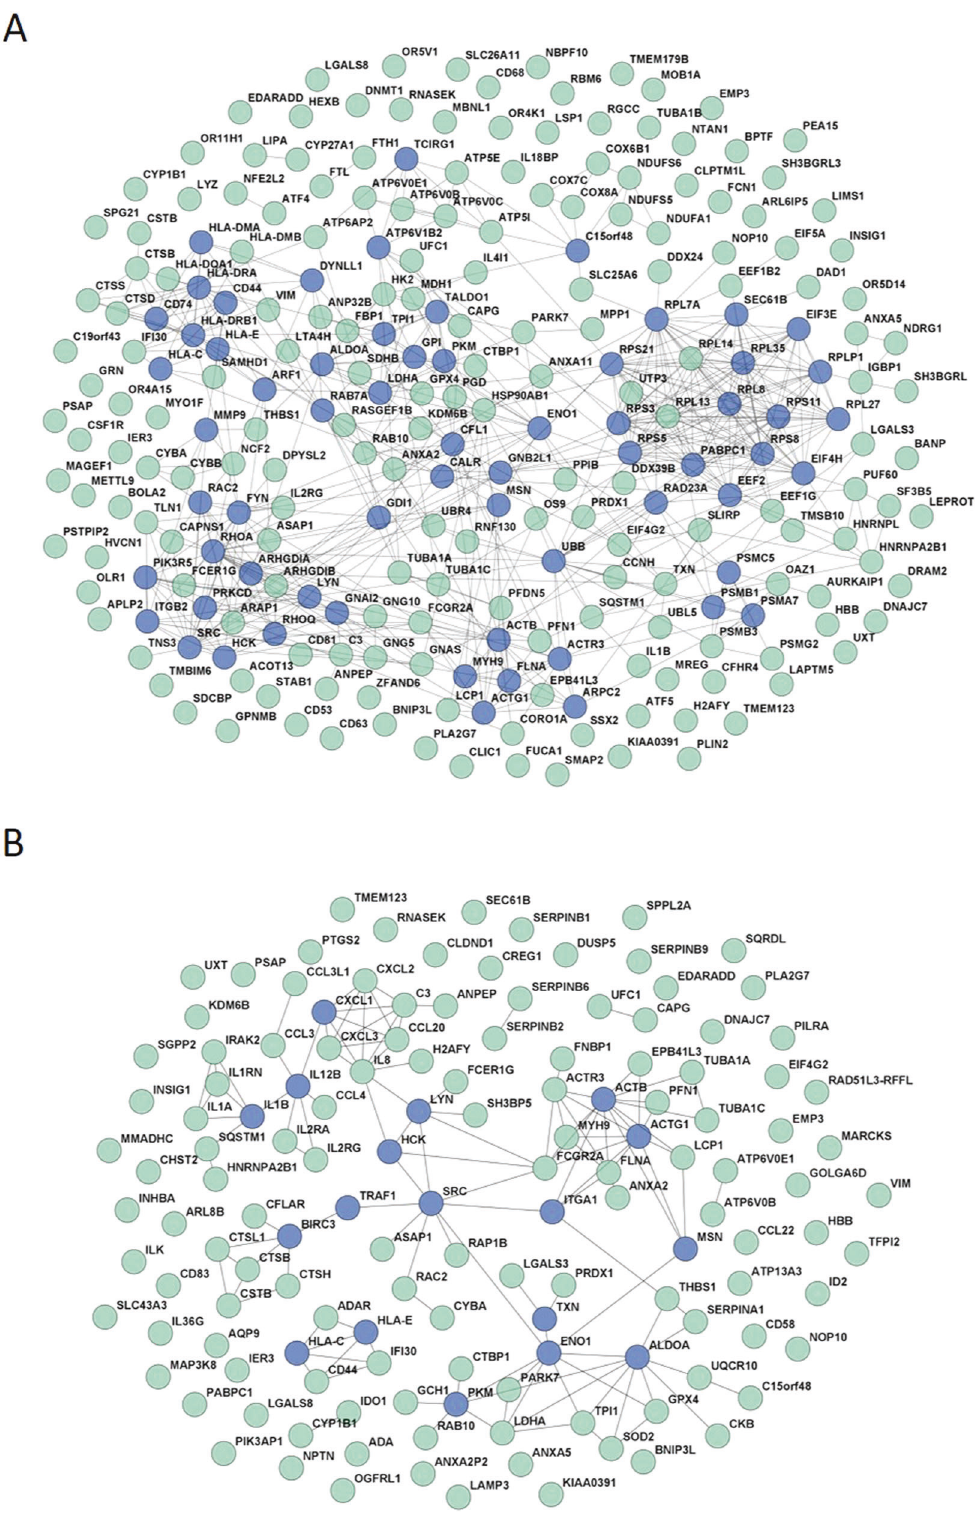
Fig. 2 Protein-protein interaction network. Protein ‑ protein interaction network of differentially expressed genes in untreated monocytes ( A ) and after stimulating monocytes with LPS ( B ) The spheres represent the genes (nodes) and the lines represent the direct interactions (edges) between differentially expressed genes. Hub genes are shown in dark LPS-stimulated monocytes) in the remaining cases and controls. The Gene expression analysis by Fluidigm expression levels of the different genes assessed in each condition We further assessed the gene expression of ten selected genes were signi fi cantly correlated ( p < 0.05) (Supplementary Fig. S1). differentially expressed in each condition (unstimulated and